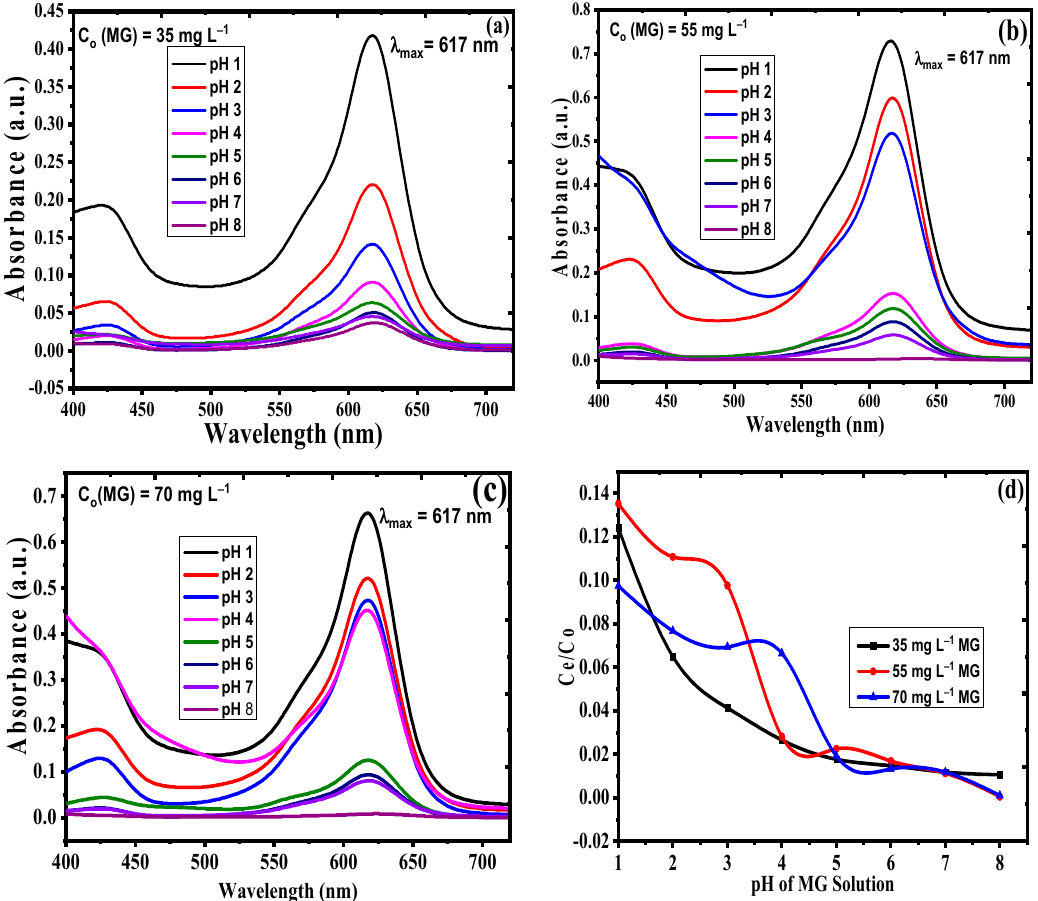
Figure 7. UV-Vis action curve for the effect of variable pH of MG solution at ( a ) 35 mg·L − 1 , ( b ) 55 mg·L − 1 , and ( c ) 70 mg·L − 1 MG concentration, and ( d ) Ce/Co curve with respect to variable pH conditions using 20 mg catalyst under 6.35 W mL − 1 ultrasonic power.